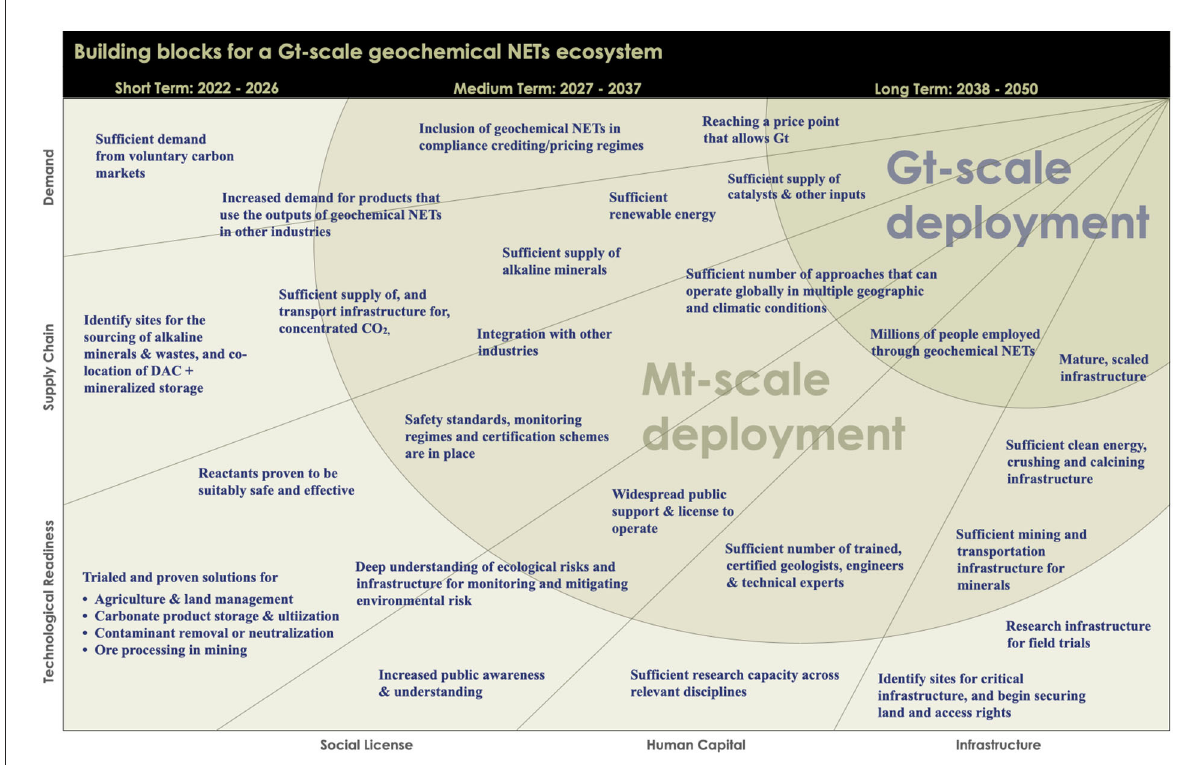
FIGURE1 Building blocks for the construction of a safe, functioning Gt-scale geochemical NETs ecosystem, across six supporting elements, according to whether they represent roadblocks for near-, medium- or long-term